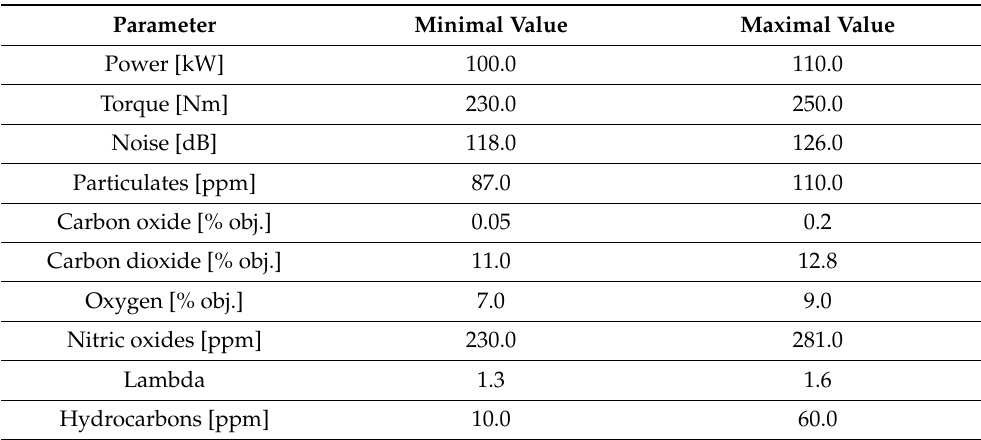
Table 7. Variability intervals for the set of relevant